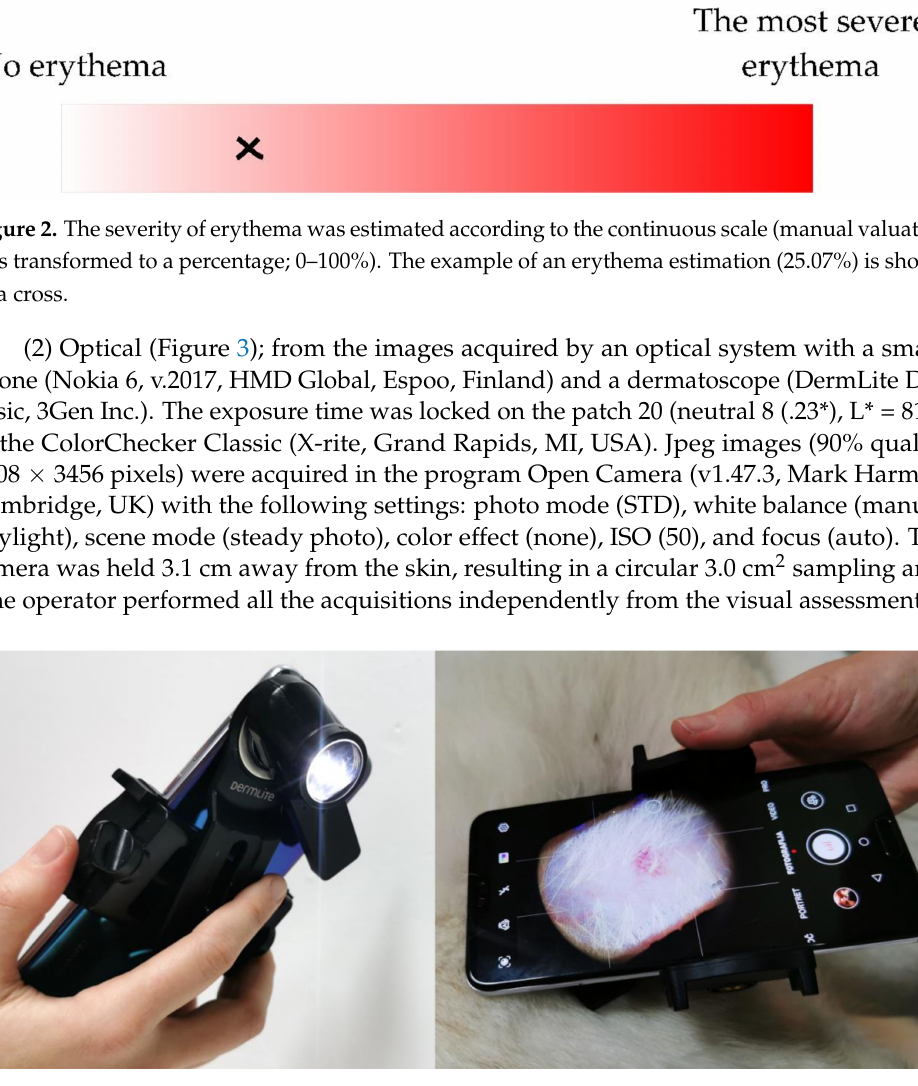
Figure 3. Optical erythema evaluation relied on the smartphone-based dermatoscopic system. After the acquisition, RGB (red, green, blue color space) images were normalized against the white standard. Three new raters (veterinarians, different from the derma- tologists in the visual erythema evaluations), performed three manual image-sampling methods (ISMs) in order to select a representative portion of erythematous skin without de- pigmented or pigmented spots and hair (Figure 4). Each of raters executed image sampling twice. At least one month passed between the original and a repeated image sampling. The first ISM included manually selecting 60 representative pixels (PT). Secondly, pixels from two small (SQ2) or one large square (SQ1) were considered. Typical blue ( B ), green ( G ), and red ( R ) values were calculated as an average from all the selected pixels. Different EIs were estimated